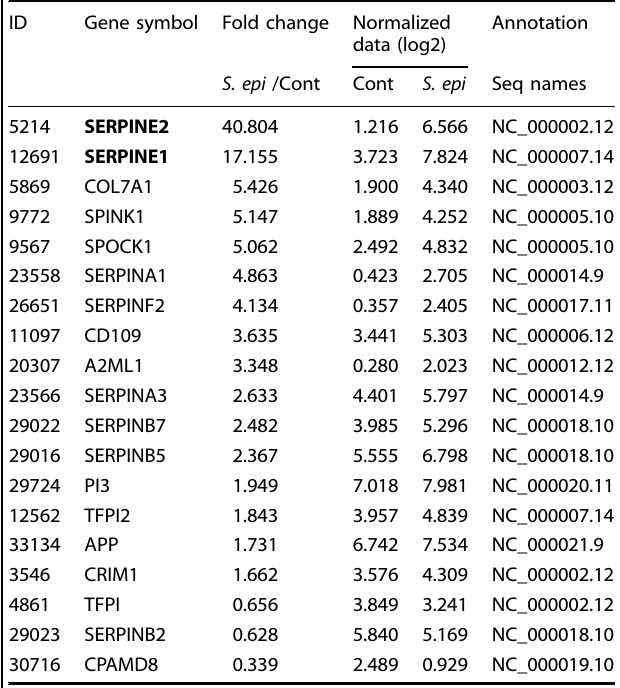
Table 1. Differential expression gene (DEG) linked with serine-type peptidase inhibitors in S. epidermidis -inoculated NHNE